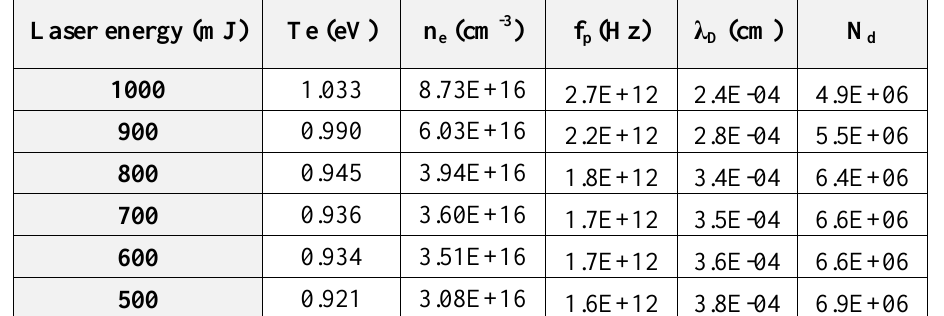
Table 3: Plasma parameters for CuO:Pb at X=0.8 in Vacuum with different laser energy. Laser energy (mJ)